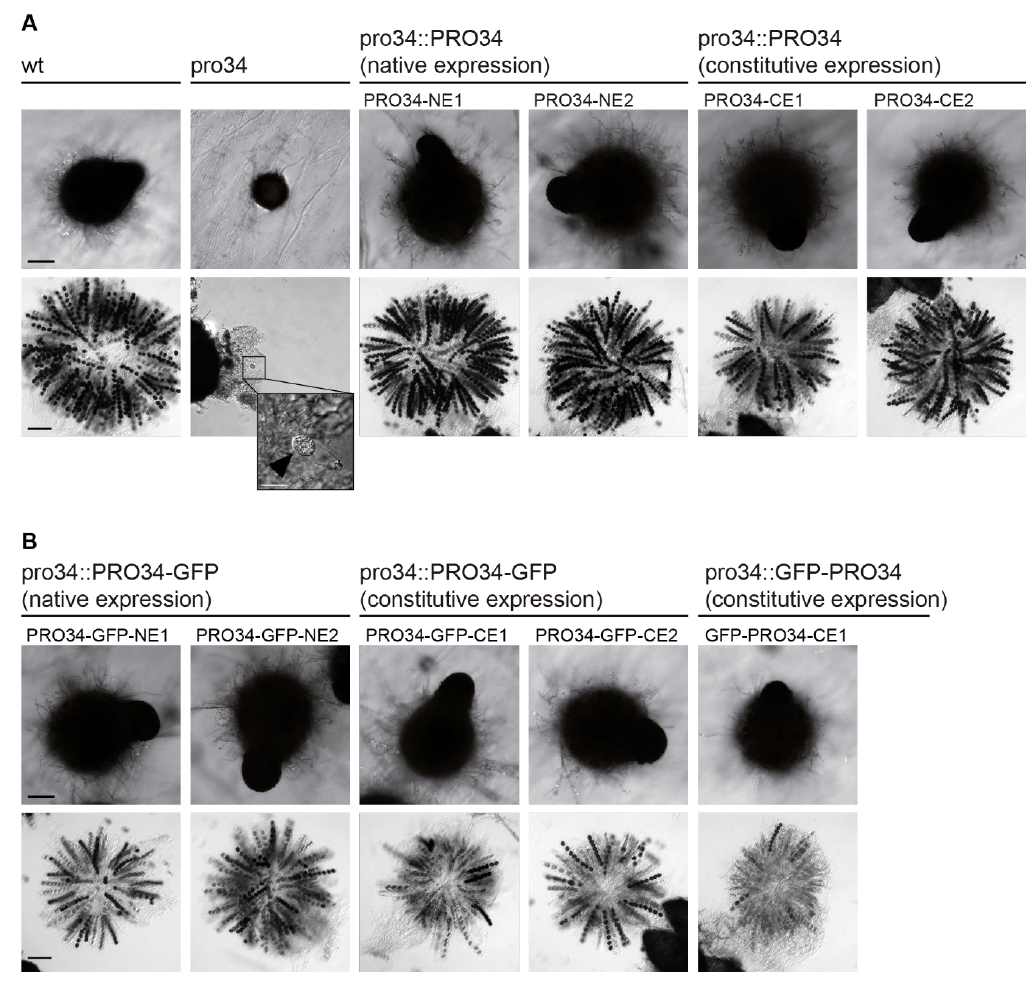
Figure 1. The sexual phenotype of pro34 and complemented strains. Strains were grown for seven and ten days on BMM for assaying perithecia and asci, respectively. ( A ) The phenotype of wild type, pro34 and transformants with native pro34 gene. Wild type (wt) generates black, pear-shaped fruit- ing bodies with mature black ascospores, while pro34 generates immature black spherical protoper- ithecia that rarely contain asci that may contain immature spores (inset, arrowhead). Fruiting body and ascospore formation is restored by integration of wild-type pro34 controlled by the native pro- moter (NE) and the constitutive A. nidulans gpd promoter (CE). The black scale bar is 100 µm; the white scale bar is 20 µm. ( B ) The phenotype of transformants with PRO34 to GFP fusions. Fruiting body formation is restored by GFP fusions, regardless of the fusion site and the promoter, but asco- spore formation is not restored to wild-type levels. The black scale bar is 100 µm.